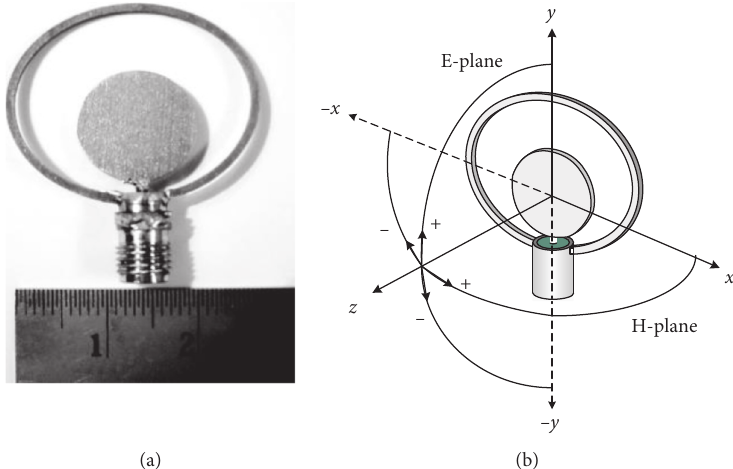
Figure 9: Prototype antenna and the coordinate system of the antenna. (a) Prototype antenna. (b) Coordinate system.